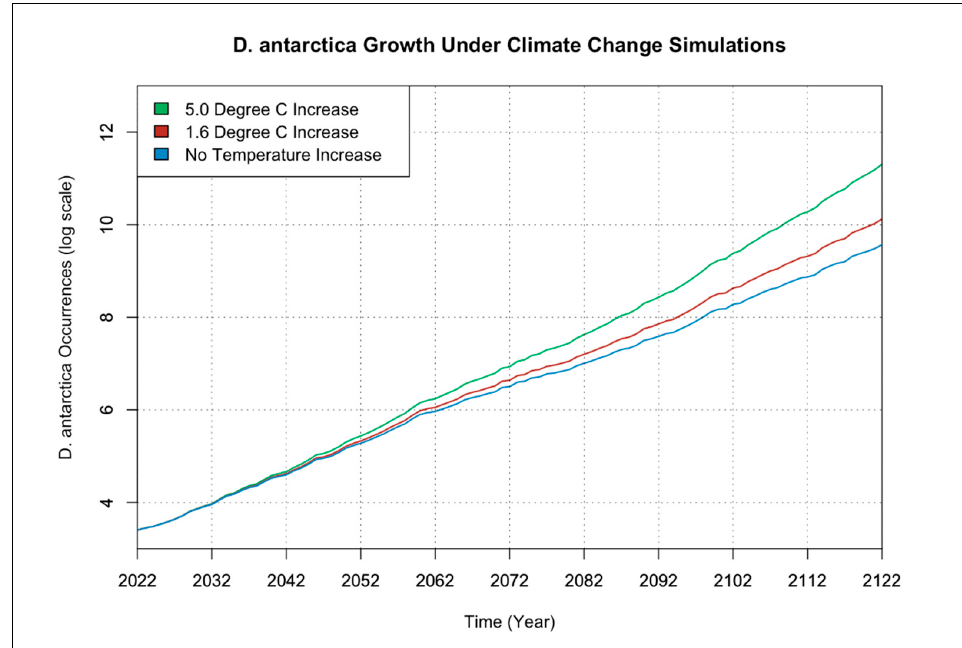
Figure 4. D. antarctica Occurrences Under No Temperature Increase, 1.6 °C Temperature Increase and 5.0 °C Temperature Increase Simulations (2022–2122).